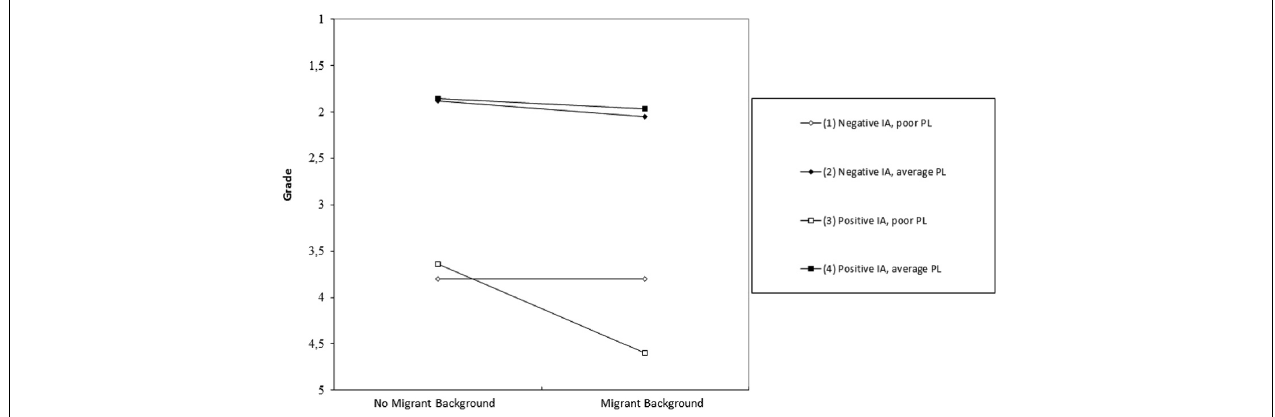
FIGURE 1 | Grade as a function of migrant background, performance level (PL), and implicit attitude (IA). Coding: Positive IA = − 1 SD, Negative IA = + 1